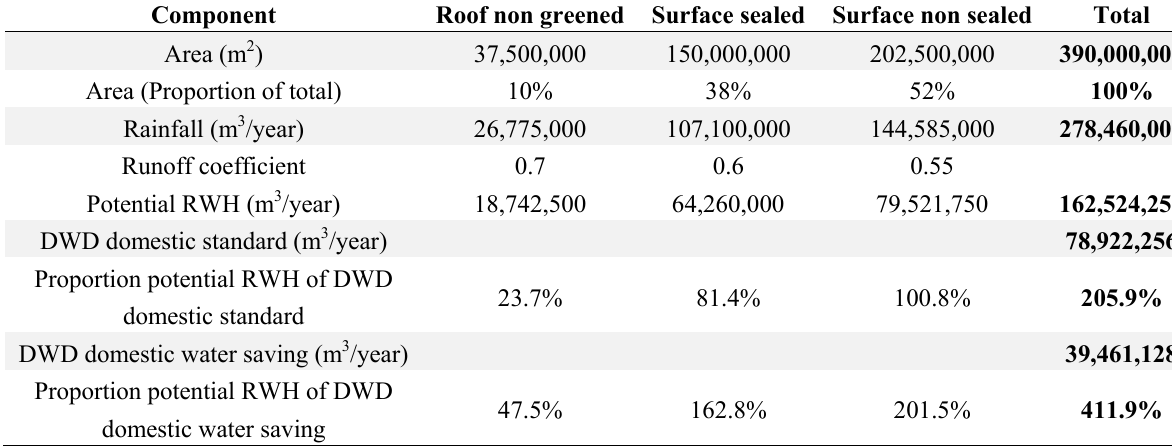
settlement areas, which have a proportion of 52% of the total city area; DWD = drinking water demand, RWH = rainwater